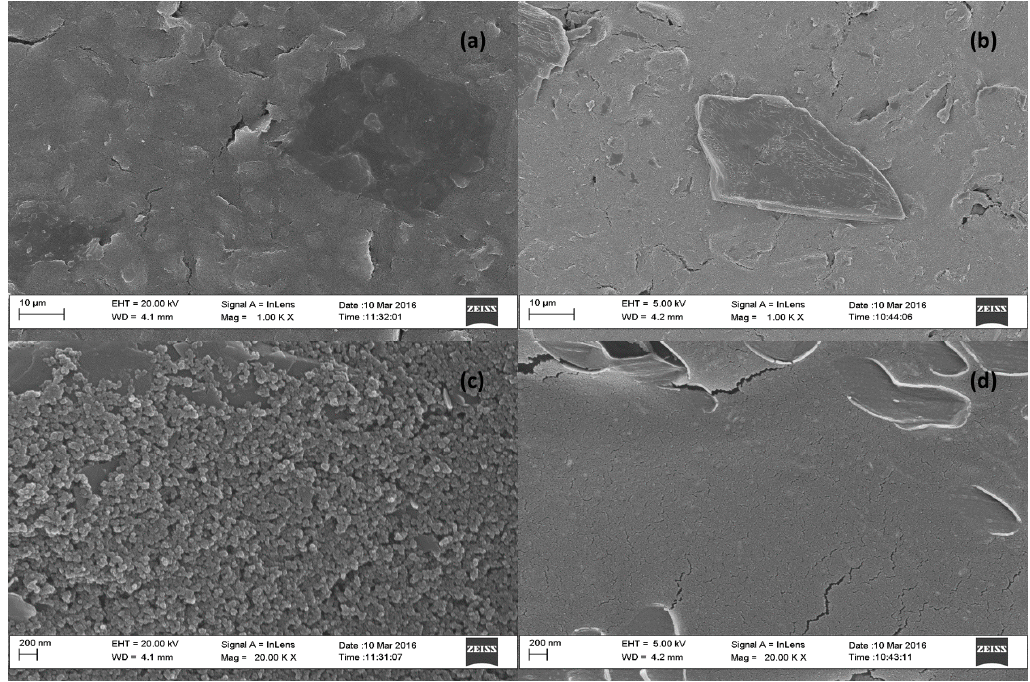
Figure 4. High resolution scanning electron microscope (HRSEM) image of ( a , c ) Bare SPCE and ( b , d ) NGr-DMG-SPCE at 1000× and 20,000× magnification.